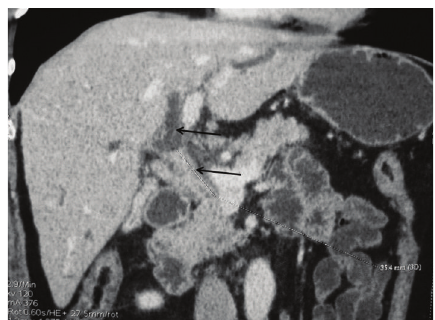
Figure 1: Abdominal CT scan: circumferential thickening of the bile duct with dilatation of the biliary tree upstream.